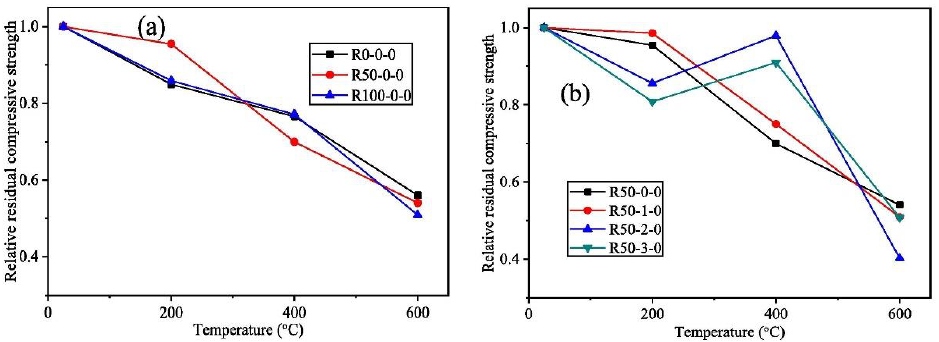
Figure 13. Influence of elevated temperatures on the relative residual compressive strength of ( a ) conventional recycled concrete, and ( b ) recycled concrete containing basalt fiber. Copyright permission is taken from [37]. Table 4. Effects of type and dosages of fiber on the elevated thermal–mechanical properties of FRAC.